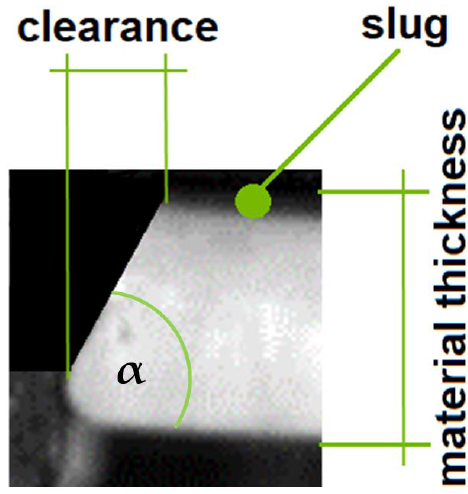
Figure 6. Determination of the ideal clearance.